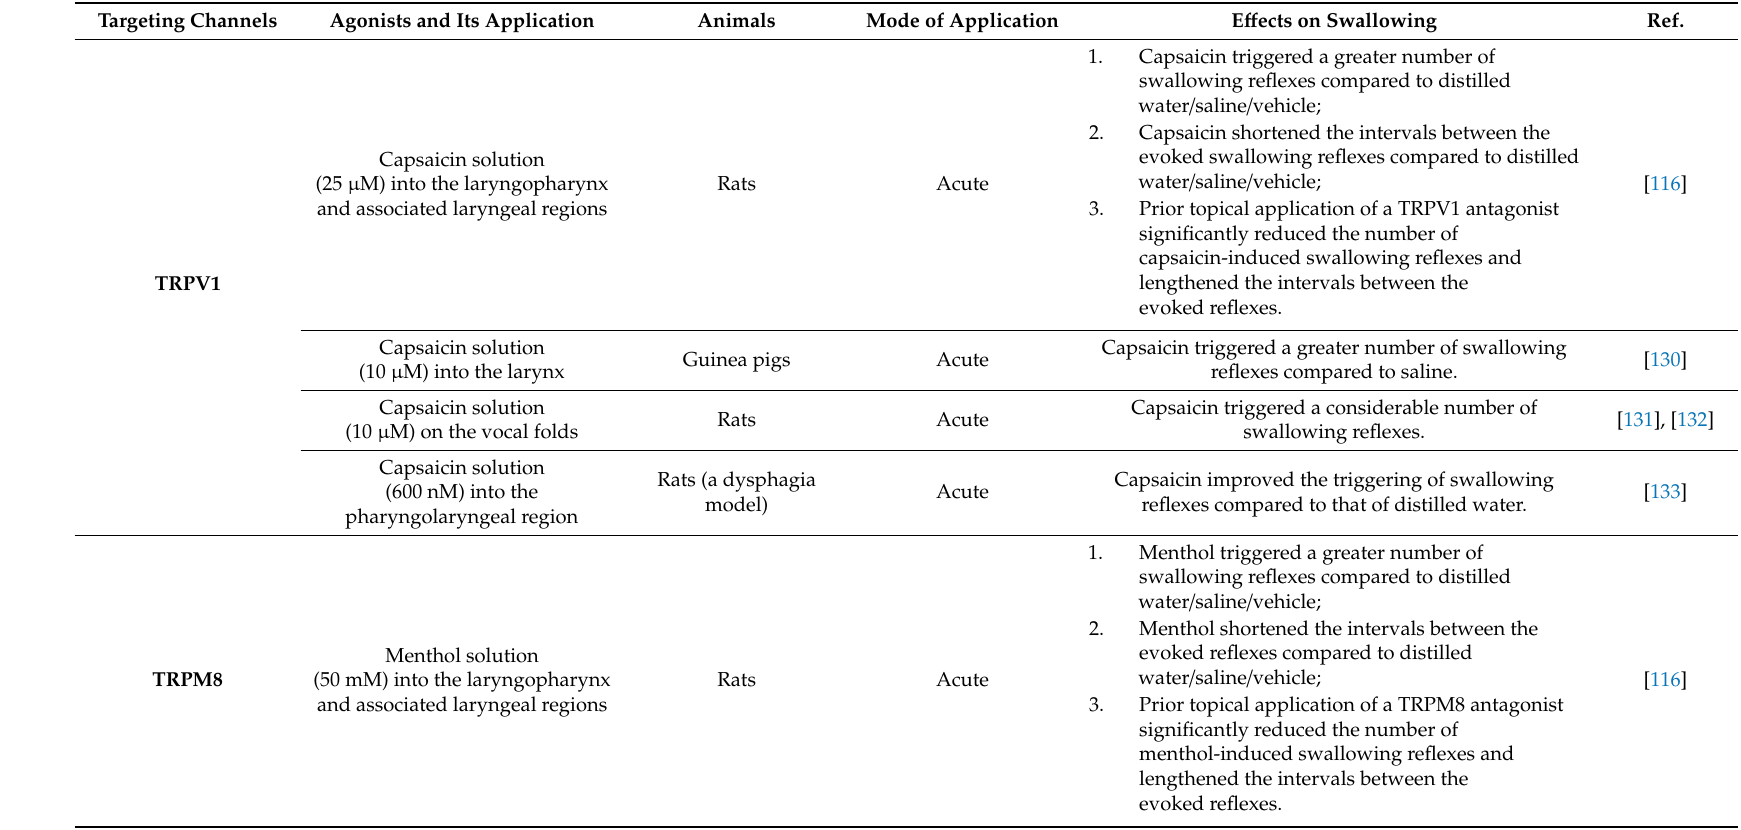
Table 1. Animal studies investigating the e ff ects of targeting chemosensory ion channels on swallowing. Targeting